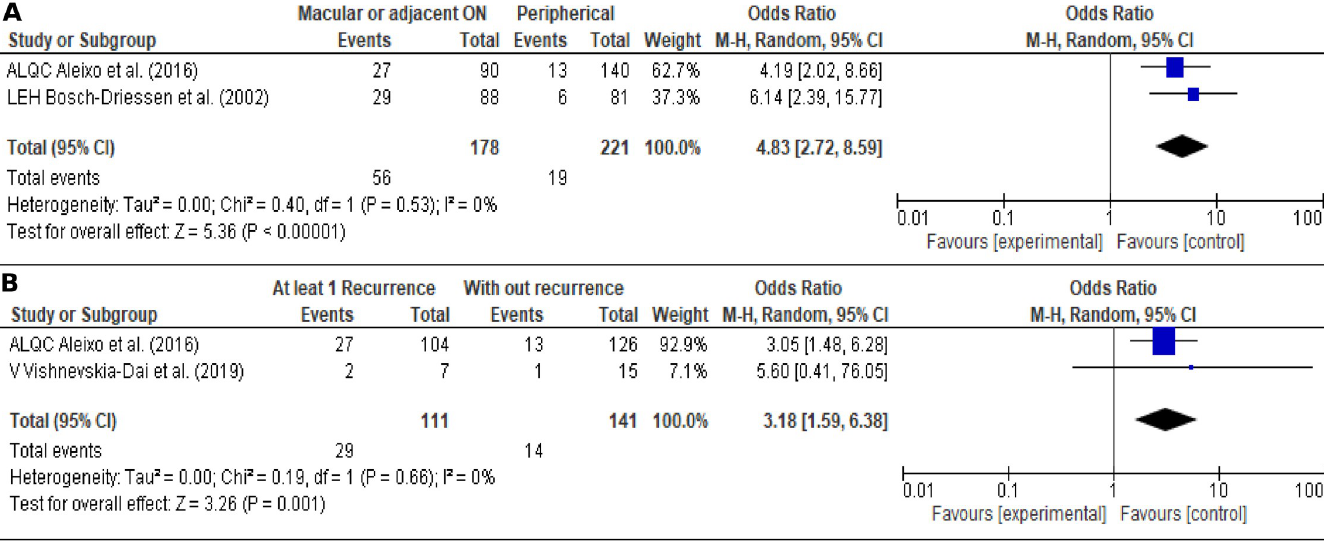
Fig 7. Blindness related factors. (A). Localization, (B). Recurrences.